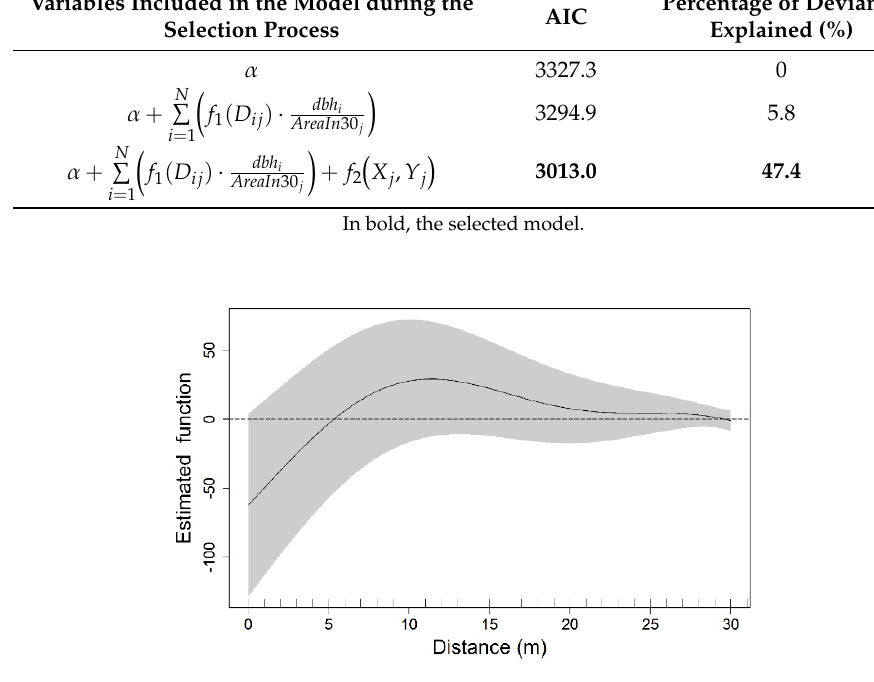
Table 2 . Summary of the variable selection process according to Akaike’s Information Criterion (AIC) and the percentage of deviance explained.